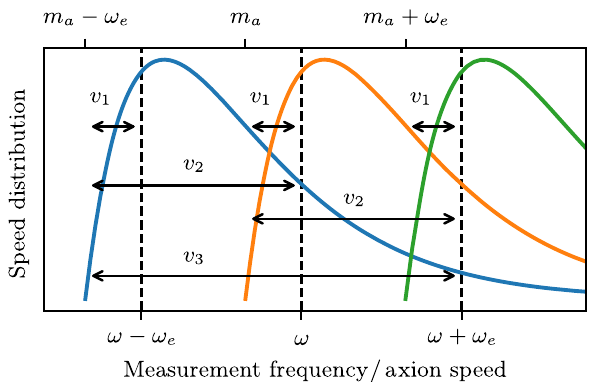
FIG. 2. Correlations between measurement frequencies ω and ω (cid:3) ω . The original speed distribution (orange), which is zero e for all frequencies below the axion mass m , is down (blue) and a up (green) modulated by (cid:3) ω . Each frequency measurement e (dashed lines) samples axions with varying speeds from both the original and modulated distributions (all denoted with double- headed horizontal arrows). For the measurement at ω − ω , only e axions with speed v 1 can contribute, but axions with speeds v 1 and v 2 can contribute to the measurement at ω , while the measurement at ω þ ω has contributions from axions with e speeds v 1 , v 2 , and v 3 . ω − ω is correlated with ω due to the e contributions from axions with speed v 1 , while ω is correlated with ω þ ω due to contributions from axions with speeds v 1 and e v 2 . Similarly, ω − ω is correlated with ω þ ω because of axions e e with speed v 1